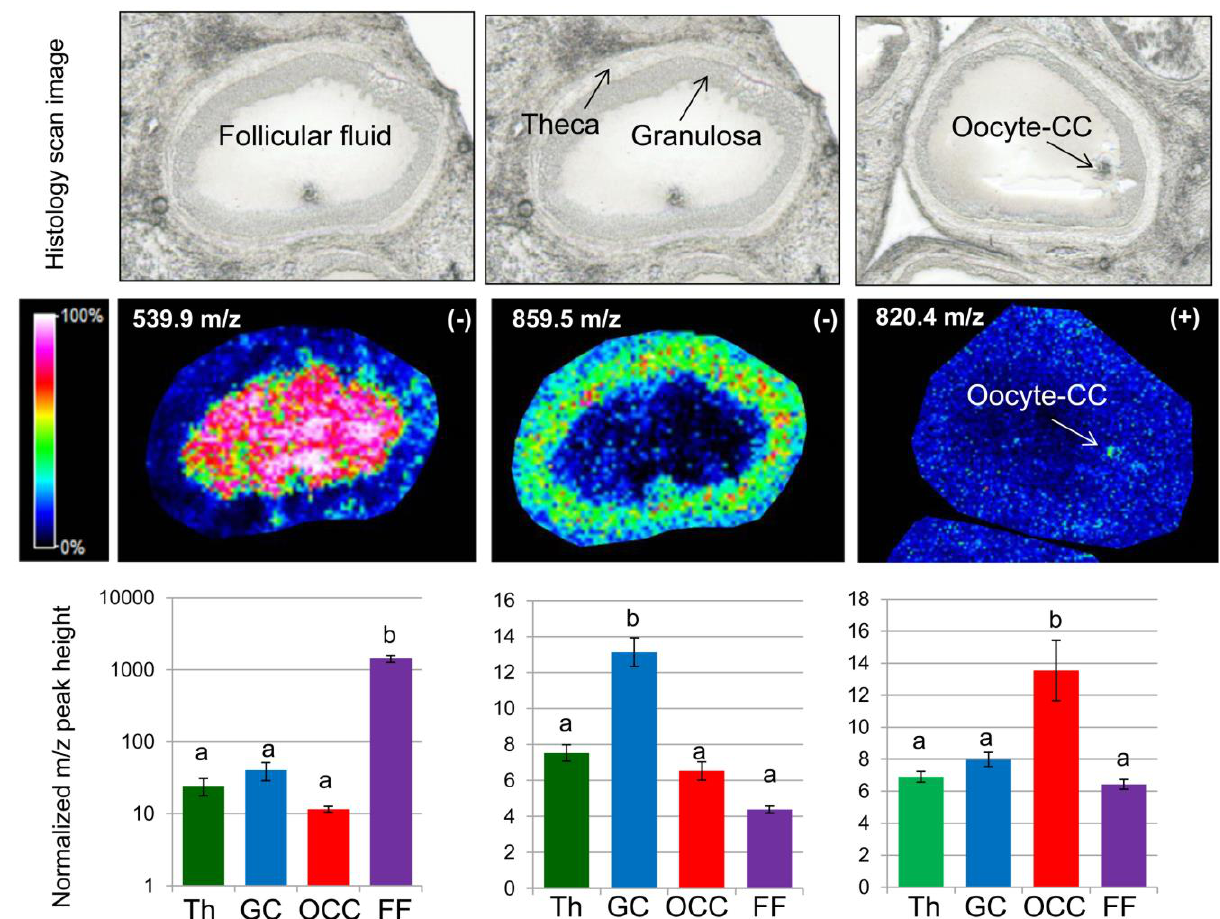
Figure 7. Single ion intensity maps and quantification of three lipid species measured at m/z 539.9, m/z 859.5 (in negative ion mode) and at m/z 820.4 (in positive ion mode), which showed their greater abundance in different follicular compartments—follicular fluid (FF), granulosa cells (GC) and oocyte-cumulus complex (OCC)—of individual follicles. Histograms present the mean values ± standard errors (SEM) of the ion intensities (normalized peak height) measured at 12 positions throughout theca, GC, OCC and FF